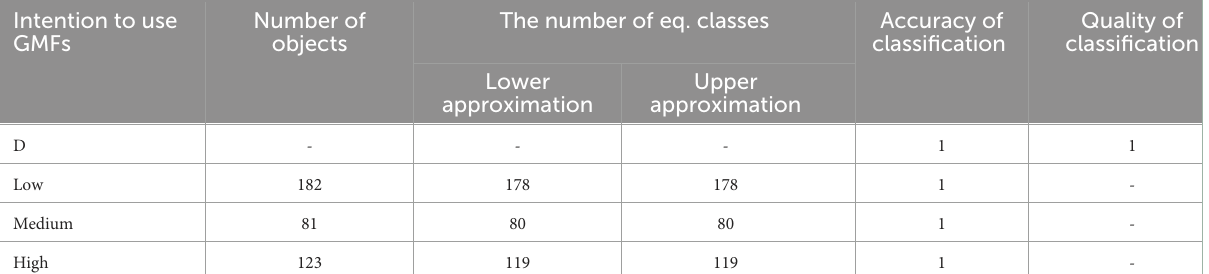
TABLE 4 Accuracy and quality of